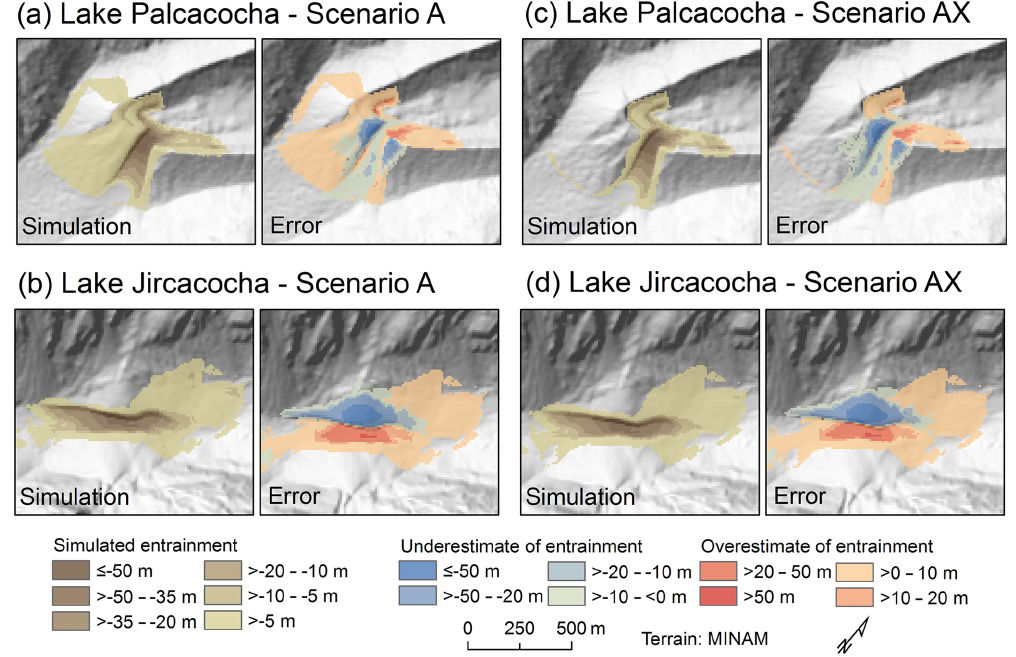
Figure 7. Simulated versus reconstructed entrainment patterns for scenarios A and AX. The total entrained height and the difference between simulated and reconstructed entrainment (error) are shown. (a) Lake Palcacocha, Scenario A. (b) Lake Jircacocha, Scenario A. (c) Lake Palcacocha, Scenario AX. (d) Lake Jircacocha, Scenario AX.